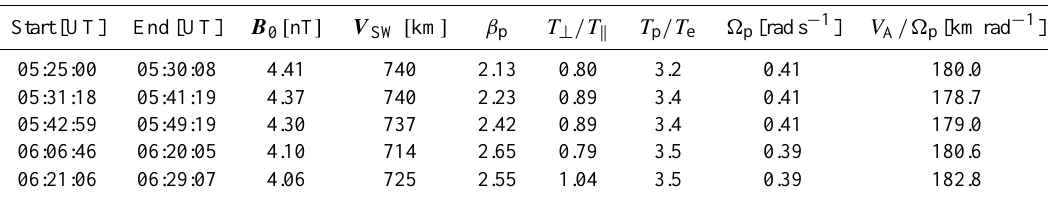
nent, the N independent windows, and measurements of the four satellites. Third, the satellite separation and configuration as well as the the flow velocity limit the accessible wave-number and frequency range. The maximum wave number